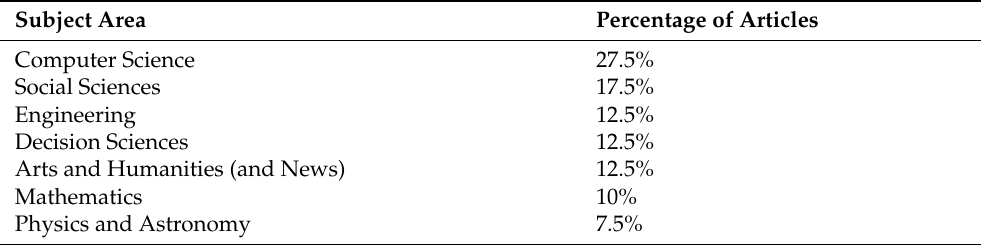
Table 1. Percentage of selected articles by field.